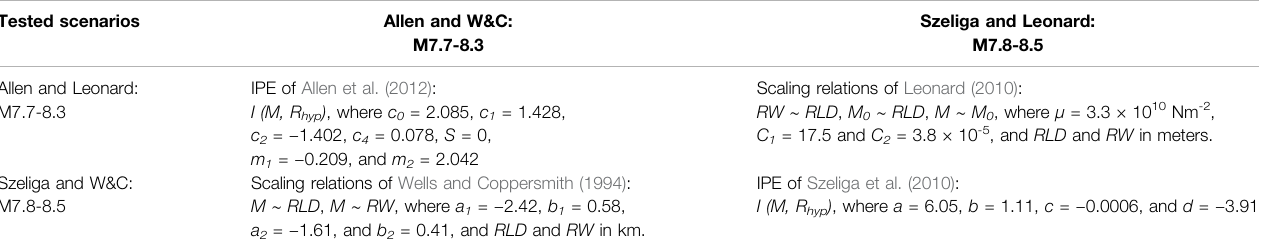
Szeliga and Leonard: M7.8-8.5